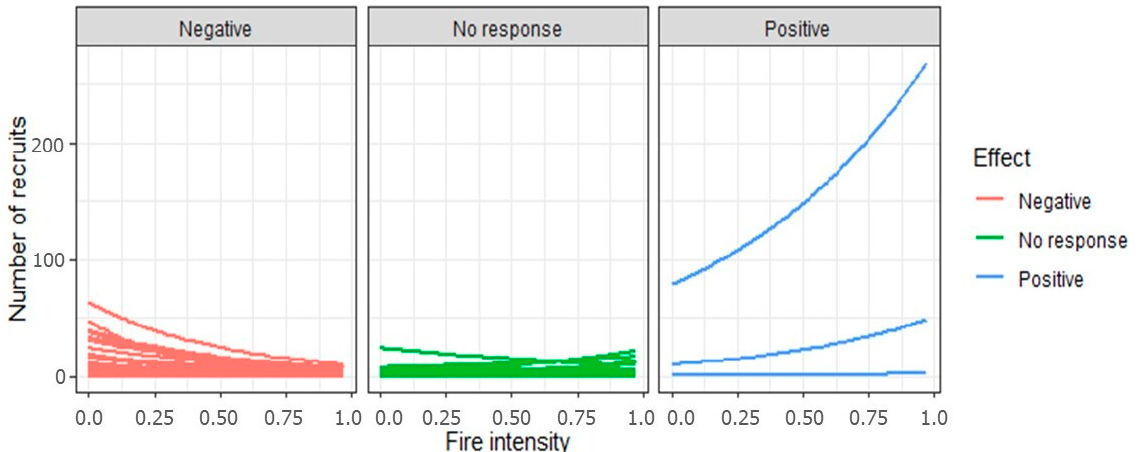
Figure 5. Relationship between the number of recruits in each each 200 50 × 50 m quadrat of each species for 89 species in Huai Kha Khaeng Forest Dynamics Plot, Thailand. Line colors represent effect of fire intensity on recruitment.